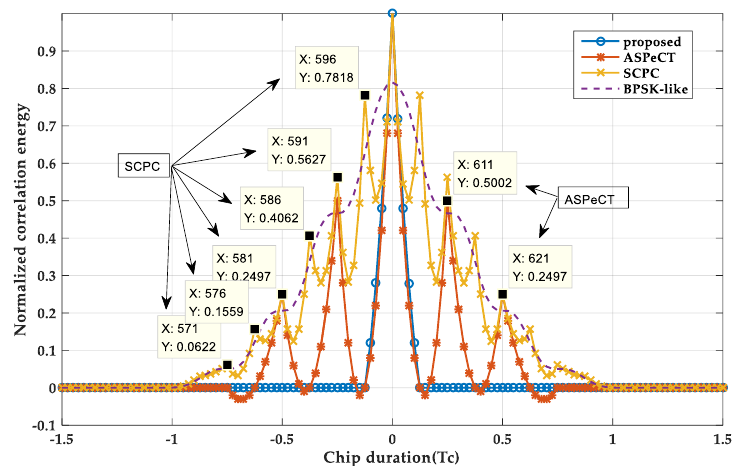
Figure 12. The 2-D acquisition result at M = 4.